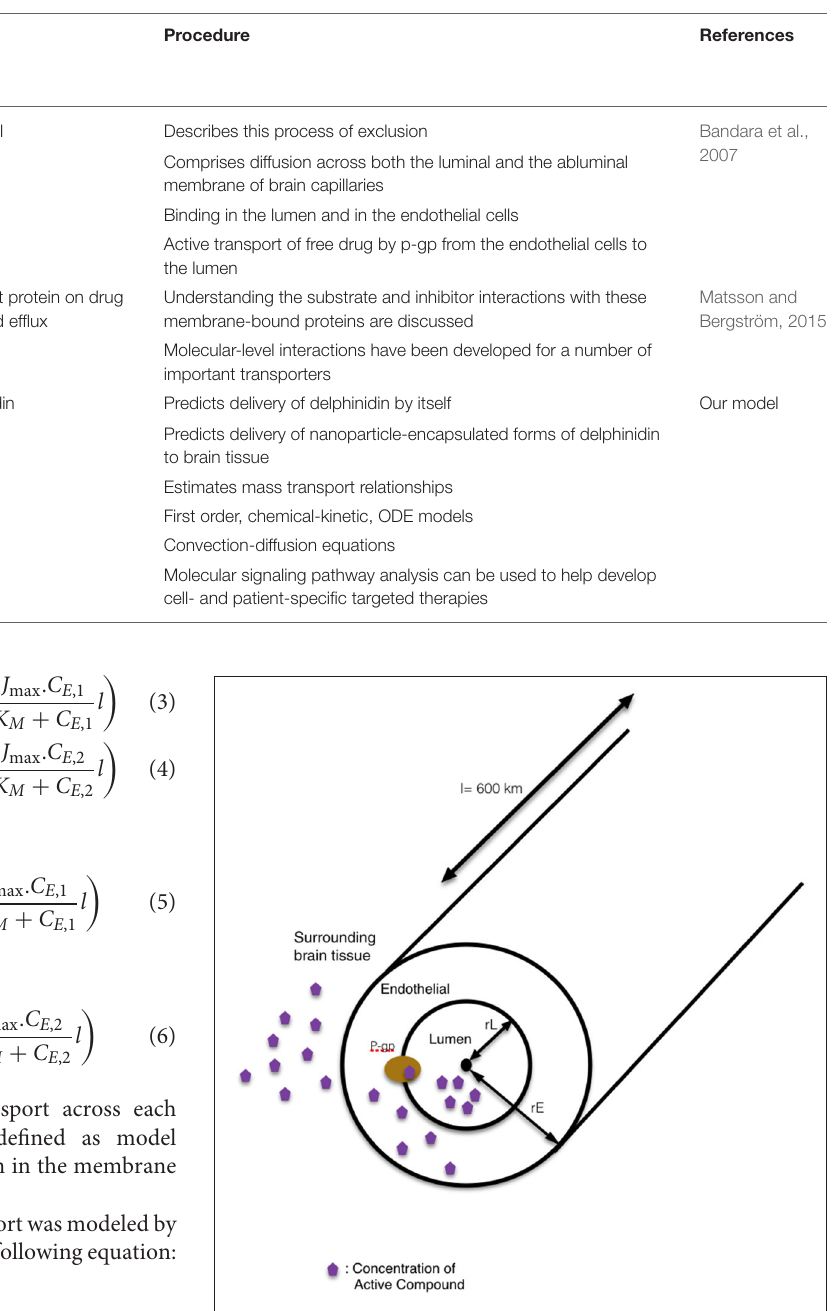
FIGURE 5 | The schematic representation of our single-tube like capillary model. In this 1D model, the blood-brain barrier is simplified into a single blood vessel with a lumen inside and surrounding tissue outside. The wall of the vessel is represented as the endothelial side. The route for the transport of compound into the surrounding brain tissue by modulation of pgp-mediated efflux is shown in the schematic diagram.